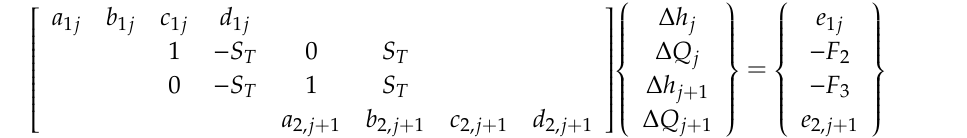
Figure 2. Inlet section of a tail tunnel with free-surface-pressurized flow.